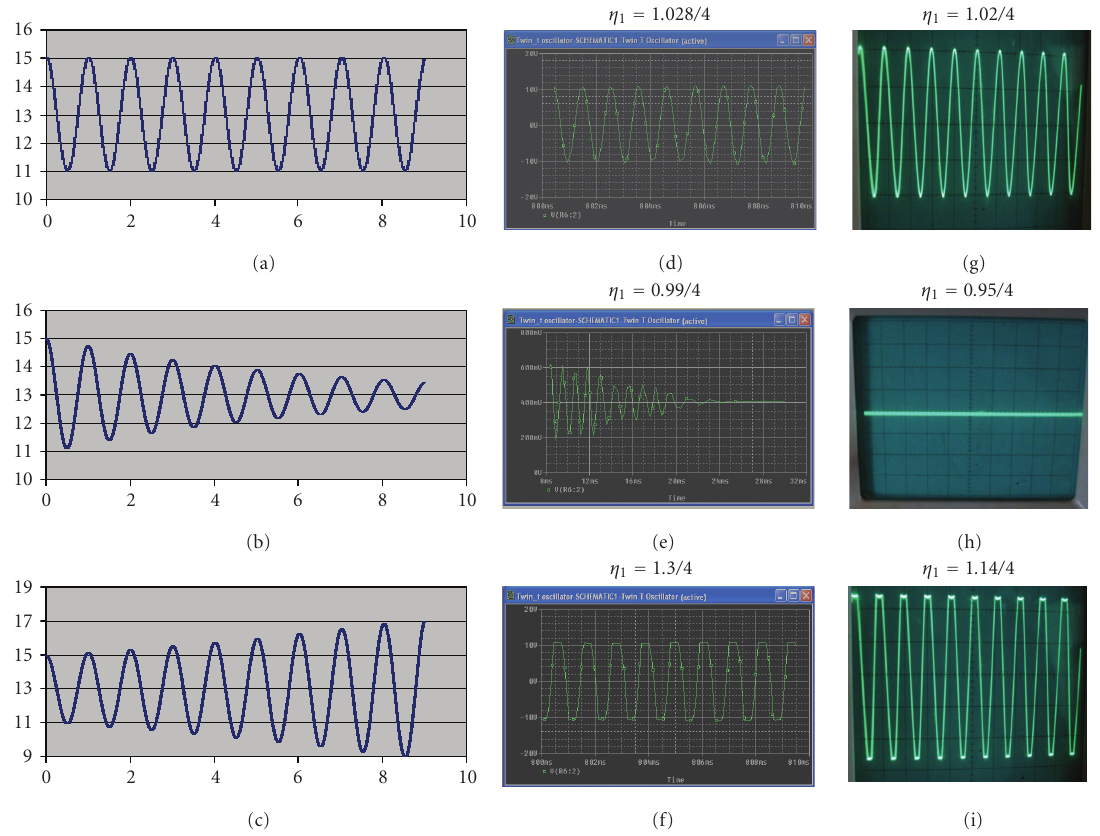
Figure 3: Waveforms of the Twin-T transient phenomenon with v i = 0 . 4V; R 1 = 1k Ω ; R a = R b = 16K Ω ; C a = C b = 10nF; X-input: 1ms/cm; Y-input: